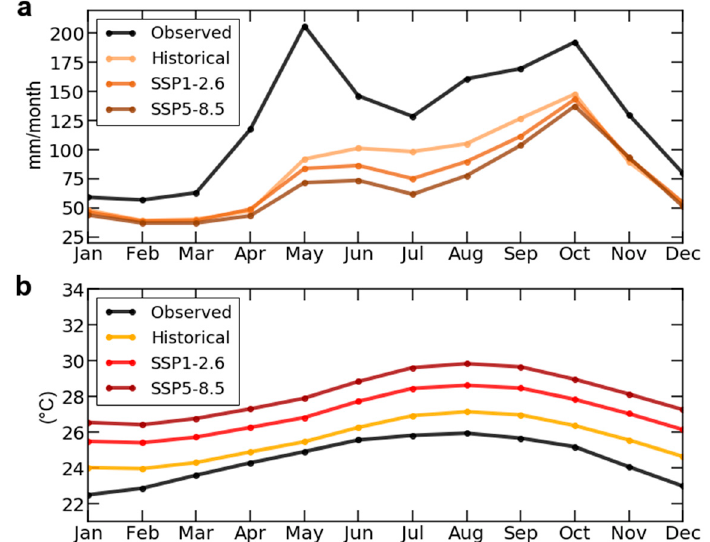
Figure 2. Observed and modeled annual cycles in precipitation and temperature in Hispaniola Island. (1950–2015). ( a ) Annual cycles in precipitation from observations (Herrera and Ault, 2017 [3]), and CMIP6’s historical and projected simulations following the SSP1-2.6 and SSP5-8.5 warming scenarios. ( b ) as panel ( a ) but for the annual temperature cycle.